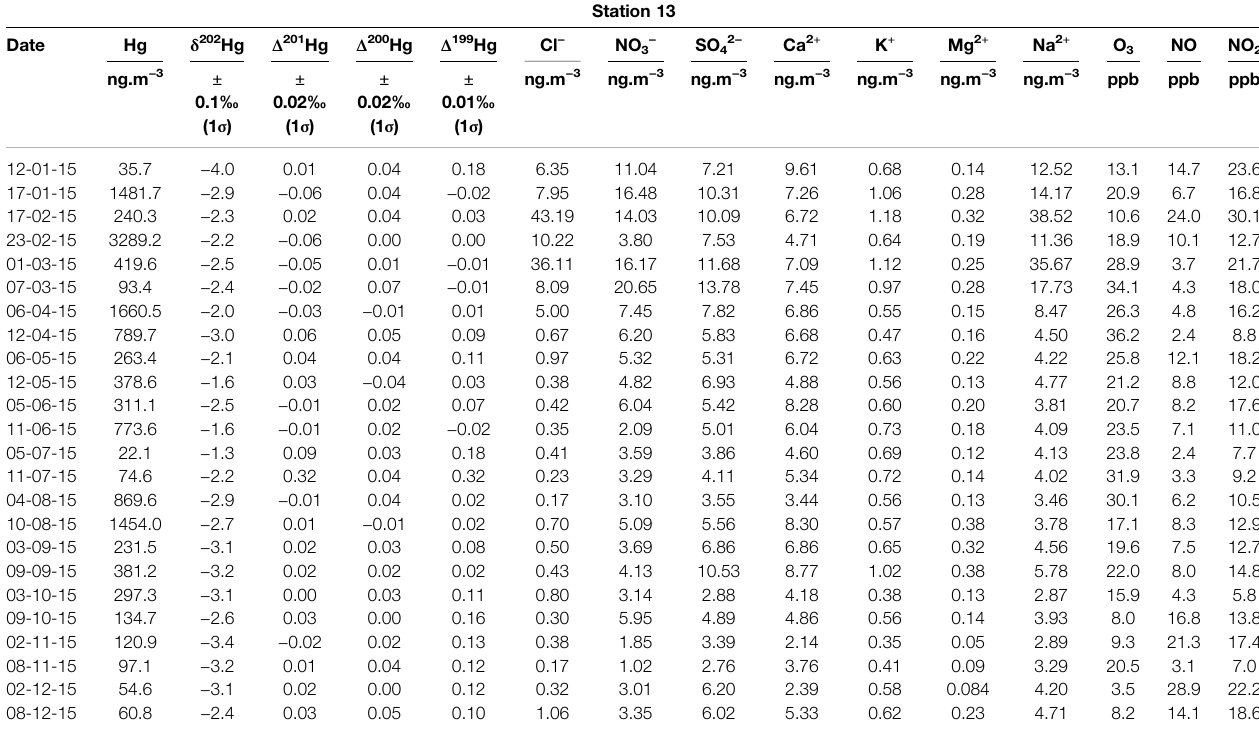
TABLE 1 | Mercury multi-isotopic compositions and major anions and cations measured in aerosol samples collected in Montreal. Corresponding O 3 concentrations, measured at station 13, are also reported.